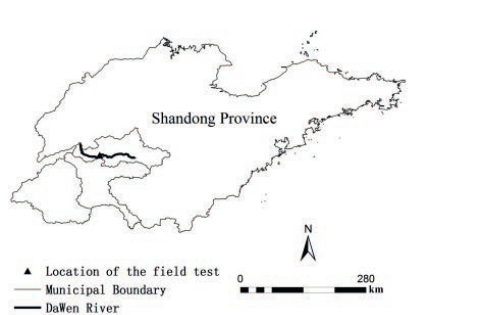
Fig. 1 Location of the field test at Dawen River, Shandong